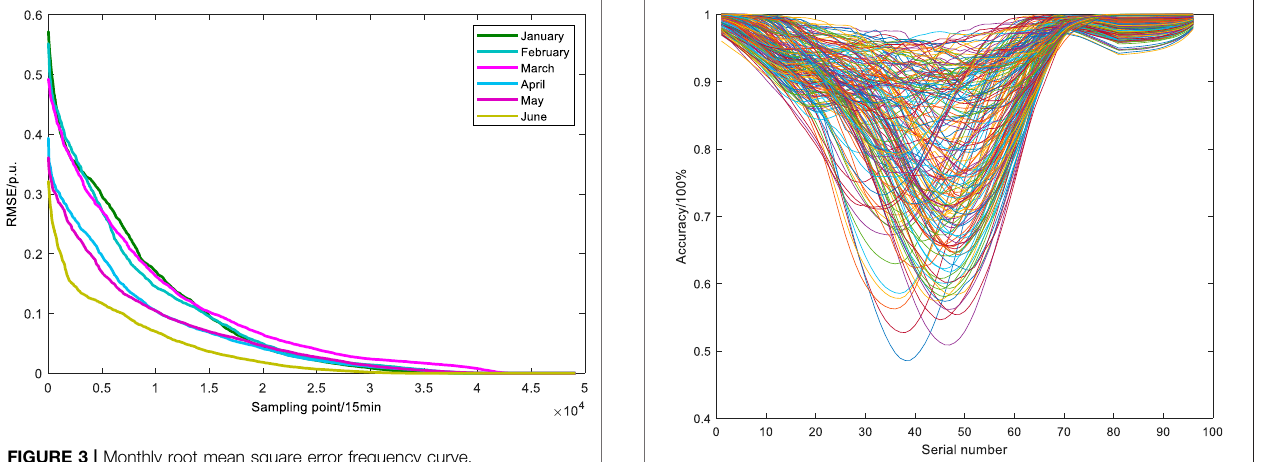
FIGURE 3 | Monthly root mean square error frequency curve. FIGURE 4 | Daily forecast accuracy curve for each day from January to June in 2019. TABLE 4 | Monthly average indexes of preliminary predictions. Monthly Monthly average accuracy (%) average RMSE (%)